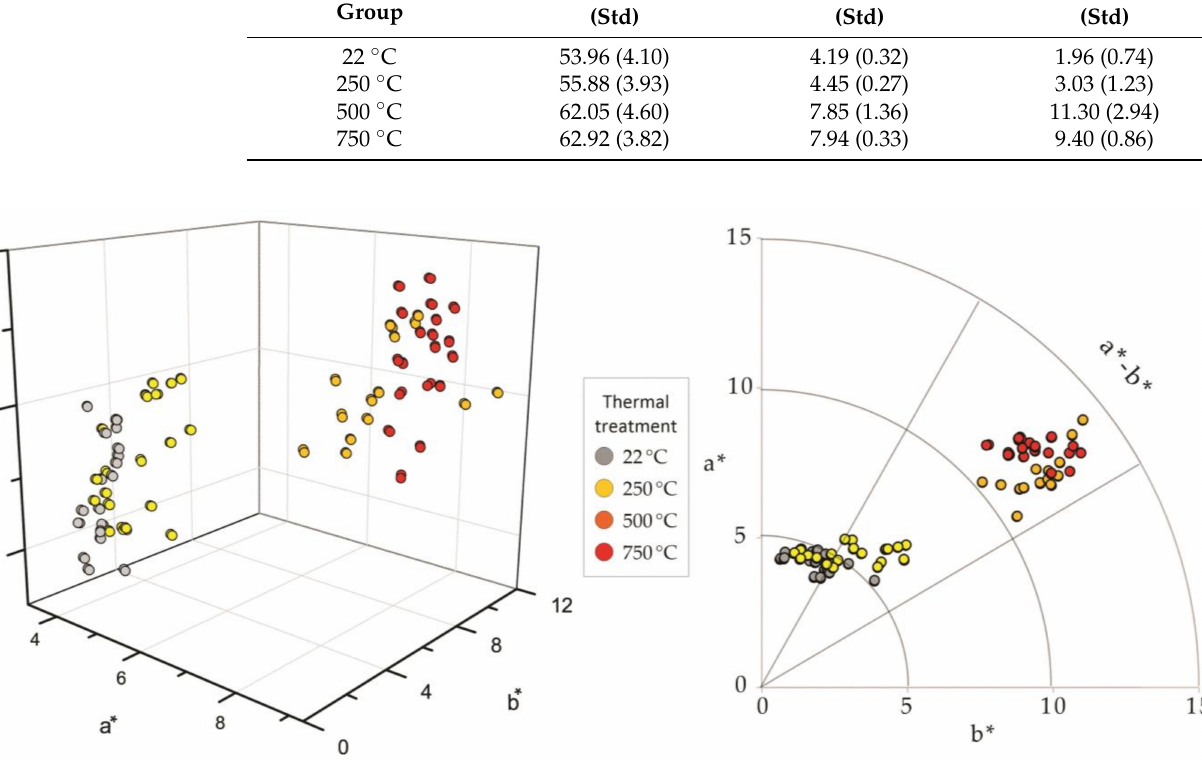
Figure 5. Colorimetric characteristics of granite samples at 22 ◦ C/250 ◦ C/500 ◦ C/750 ◦ C in the CIE L*a*b*system. L represents lightness (white to black), ‘a’ shows colors from red to green, while ‘b’ stands for yellow to blue ( left ). Red to green (a*) and yellow to blue (b*) color alteration of granite samples at 22 ◦ C/250 ◦ C/500 ◦ C/750 ◦ C ( right